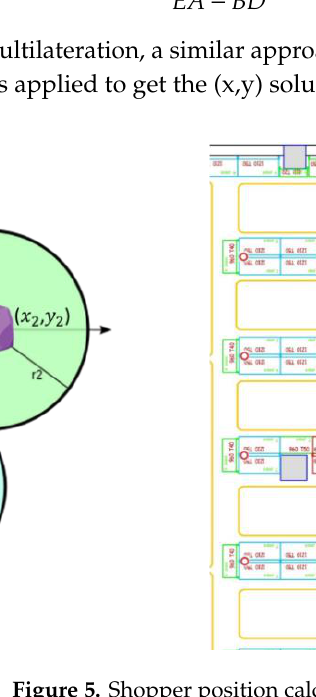
Figure 5. Shopper position calculation using trilateration.